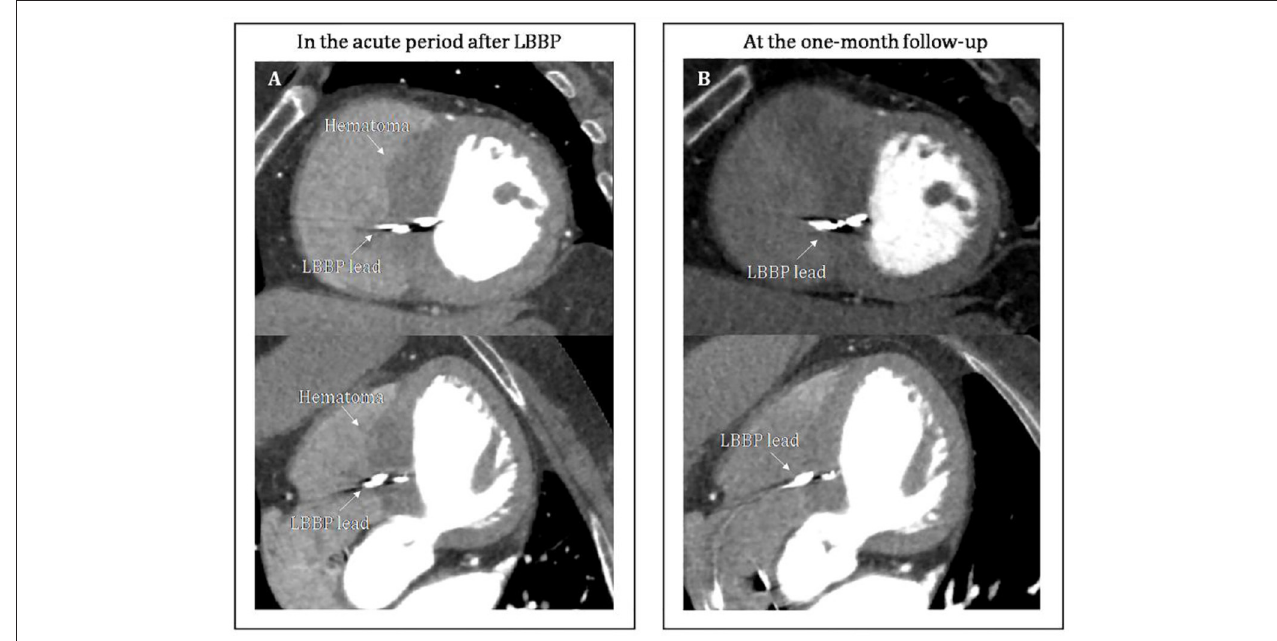
FIGURE 4 | (A) CTA showed a hematoma in the basal segment of the interventricular septum in the acute period after LBBP. On non-contrast CTA, a high-density thickening in the interventricular septum was found. Post contrast, no significant change in the enhancement was observed. (B) CTA confirmed the hematoma has resolved at the 1-month follow-up. CTA, computed tomography angiography.